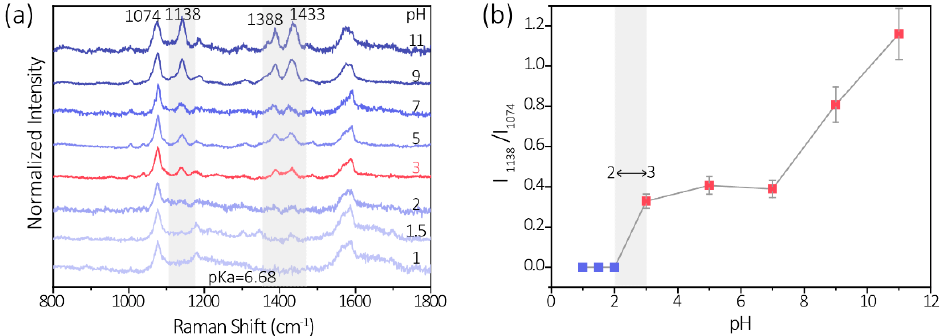
Figure 3. Influences of pH to the surface plasmon-assisted conversion of PATP to DMAB. ( a ) SERS spectra of the PATP-Au probe under various pH values (1–11). ( b ) Normalized Raman band intensities at 1138 cm − 1 of PATP-Au probe under various pH values (1–11).